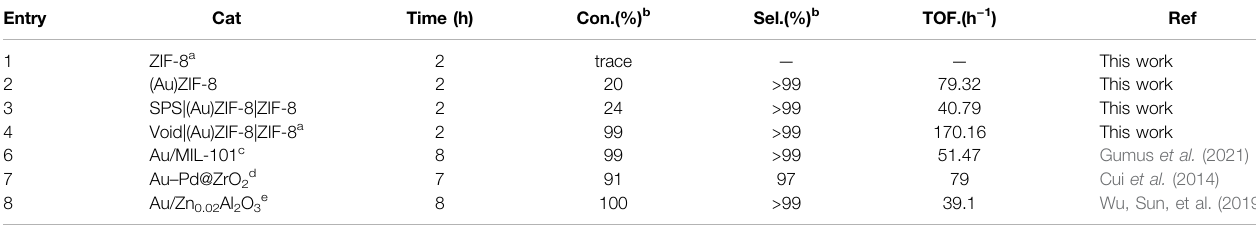
TABLE 2 | Synthesis of imines from benzyl alcohol and aniline by Void|(Au)ZIF-8|ZIF-8 one-pot cascade catalysis.